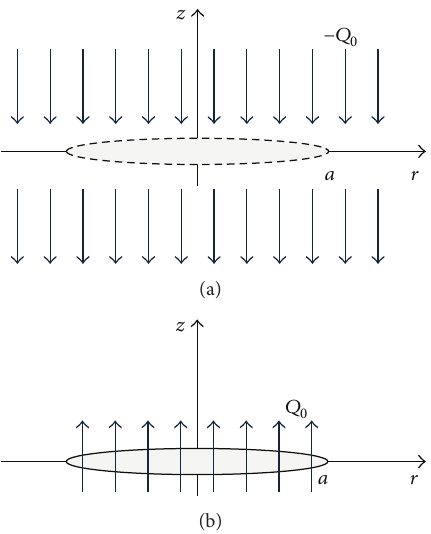
Figure 2: (a) One-dimensional heat conduction without an insu- lated barrier, (b) Two-dimensional heat conduction with an insu- lated